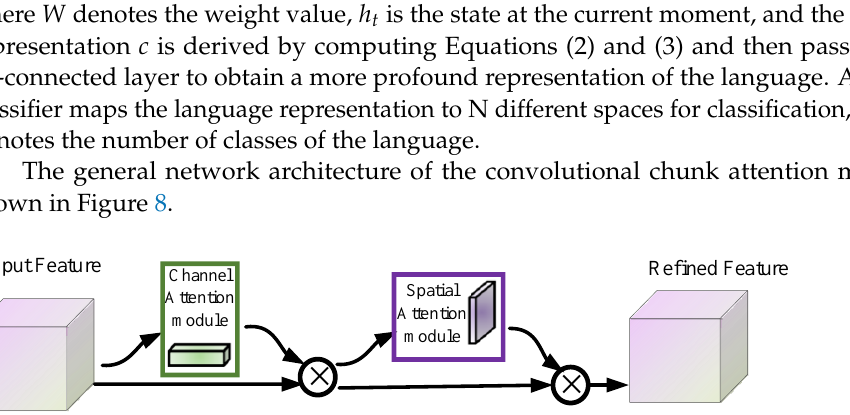
Figure 8. Convolutional block attention module.